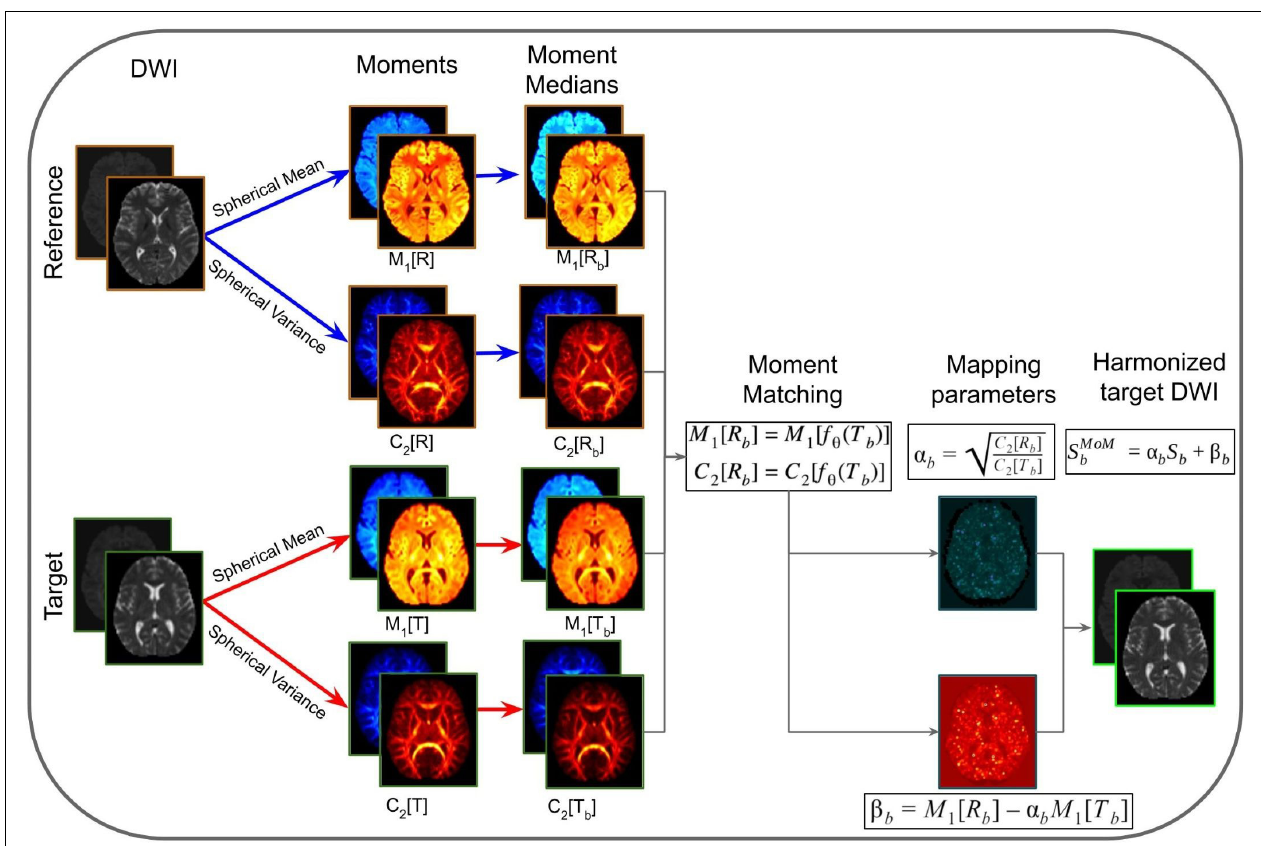
FIGURE 5 | Representation of the method of moments harmonization pipeline. The purpose of the method is to modify the DWI of the target site, to correspond to the DWI acquired in the reference site. Initially, the diffusion signal in the reference ( R ) and target ( T ) are used to compute spherical means ( M 1 [ R ] and M 1 [ T ] ) and spherical variances ( C 2 [ R ] and C 2 [ T ] ) in native space for each b-shells ( b ). The spherical moments are warped to a common space, based on the target population. Then the moment medians are calculated across subjects ( M 1 [ R b ] , C 2 [ R b ] , M 1 [ T b ] , and C 2 [ T b ] ). Afterward, the mapping parameters ( α b and β b ) are calculated per b-shell, by matching the population moments. The mapping parameters are warped to native space and applied voxel-wise to the DWI images of target site subjects, obtaining the harmonized